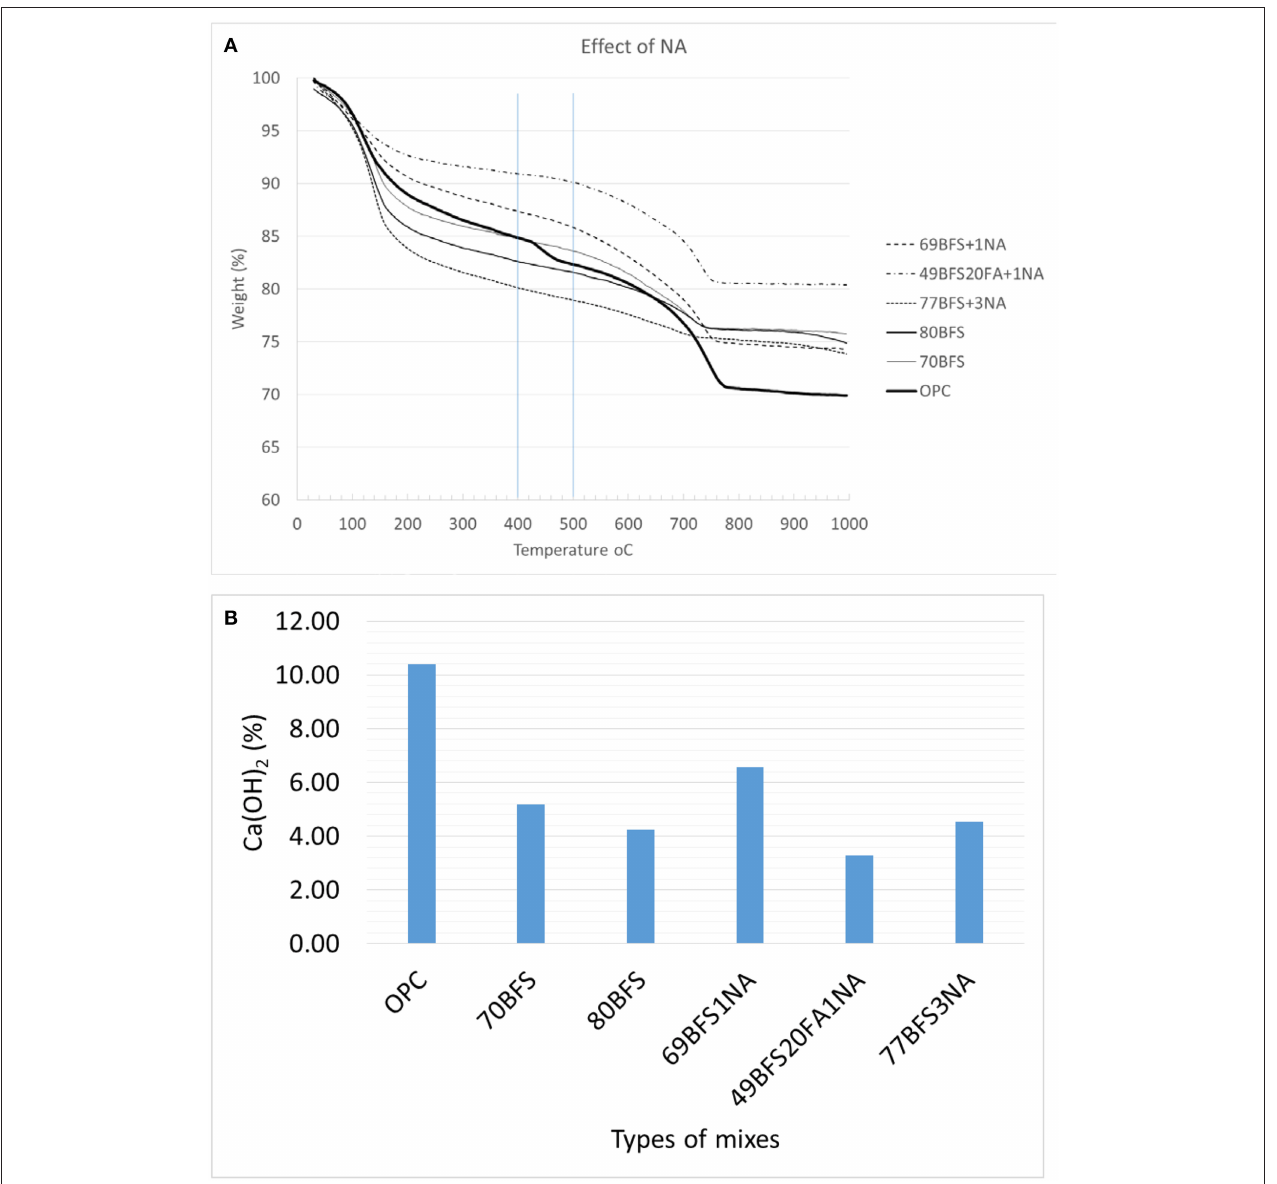
FIGURE 6 | TGA analysis (A) and Ca(OH) 2 contents (B) of HVS and HVS-FA pastes with and without nano